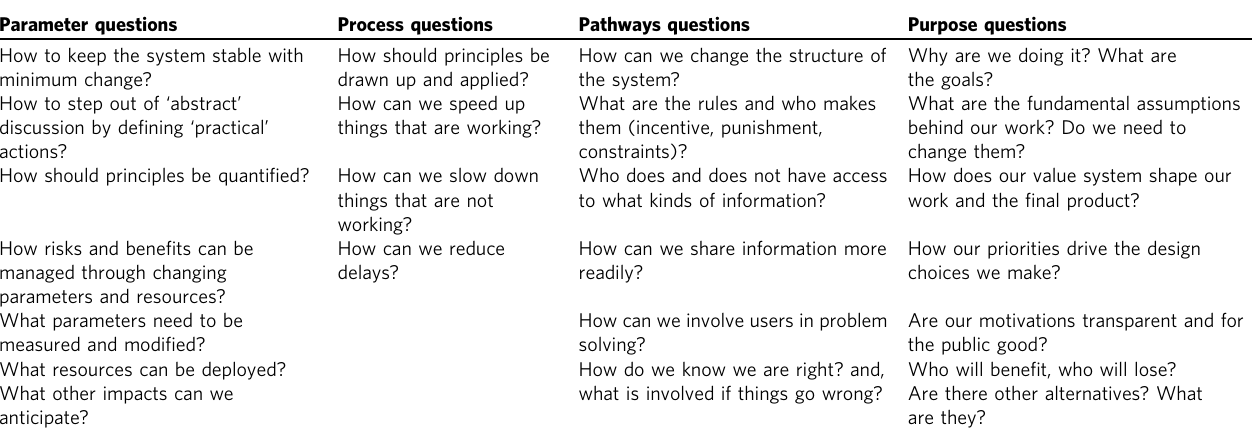
Table 2 Lines of questioning on interventions for Responsible